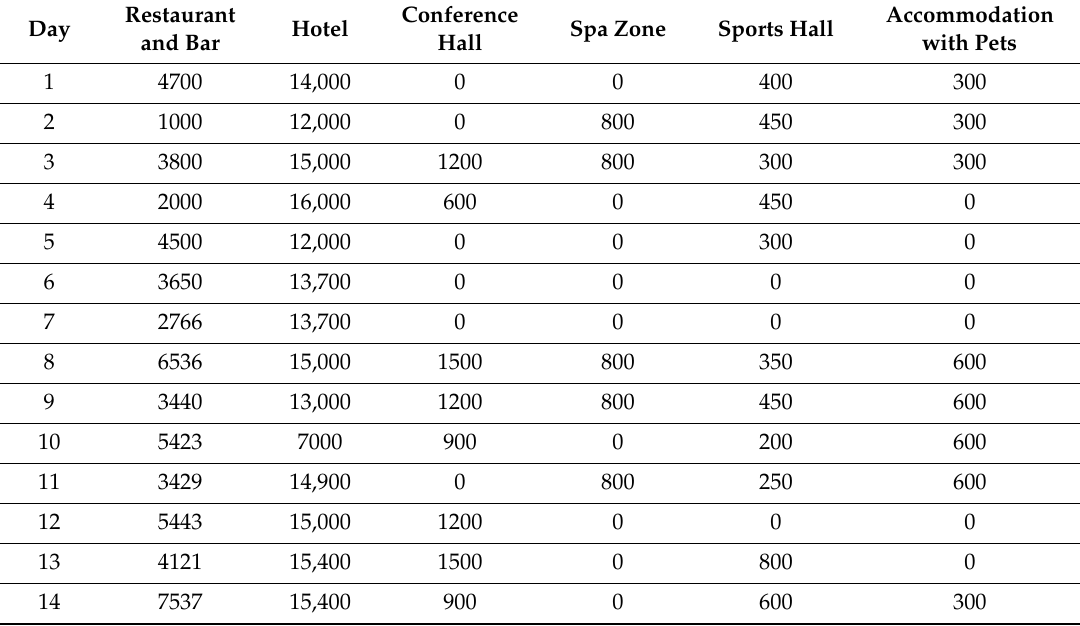
Table 4. Financial revenues from the provision of services for August 2019, US